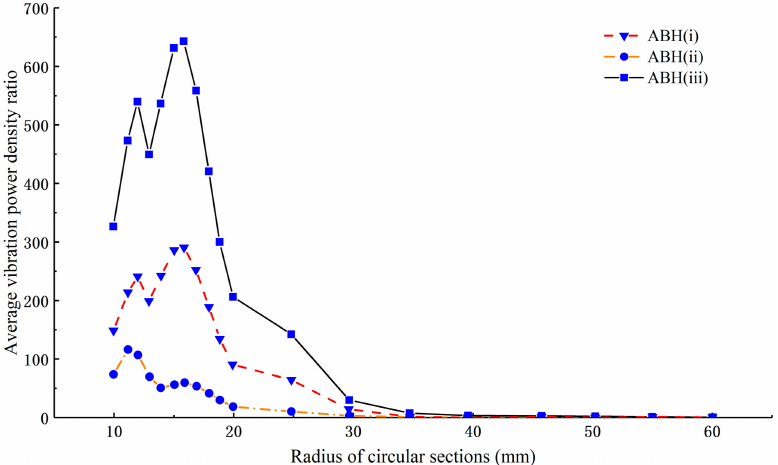
Figure 11. Average vibration power density ratios at excitation frequencies of 1088 Hz.